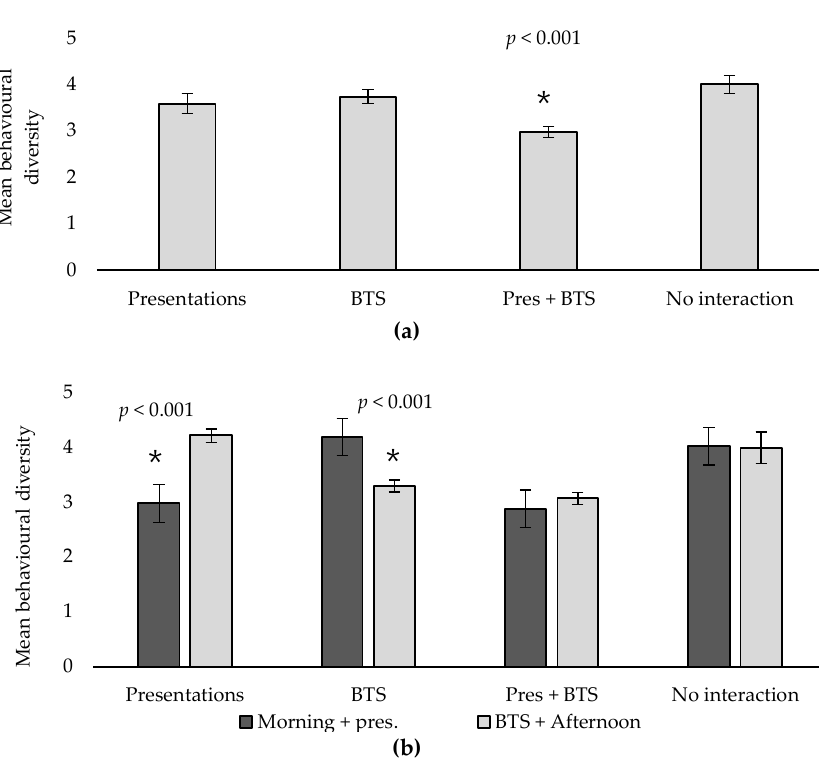
Figure 3. ( a ) Mean behavioural diversity (total number of behaviours expressed) during any given observation session across the four treatments. Error bars show standard error. Asterisks denote significant treatment differences. ( b ) Mean behavioural diversity during the two different observation blocks across the four treatments. Pres–Presentations; BTS–Behind the Scenes. Error bars show standard error. Asterisks denote significant treatment/session interactions.